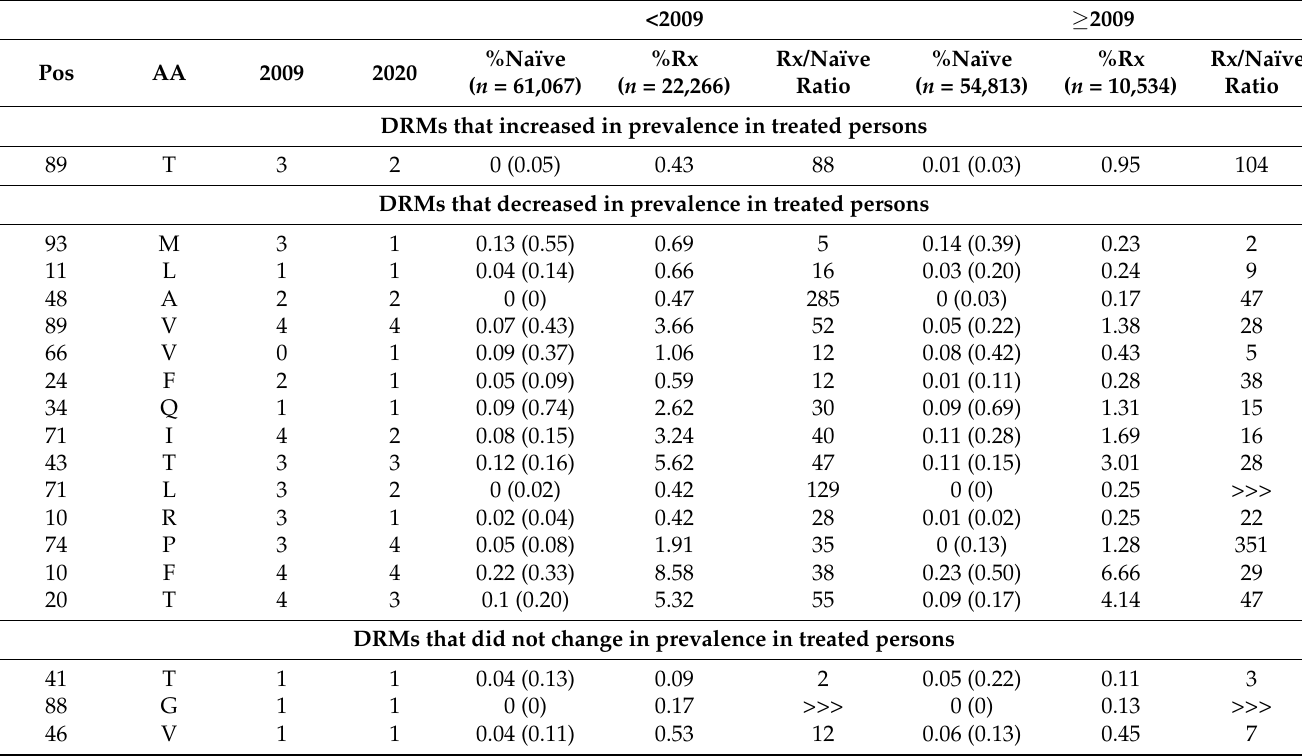
Table 6. Prevalence of Additional Nonpolymorphic PI-Resistance Mutations in PI-Naïve and PI-Experienced Persons before and after